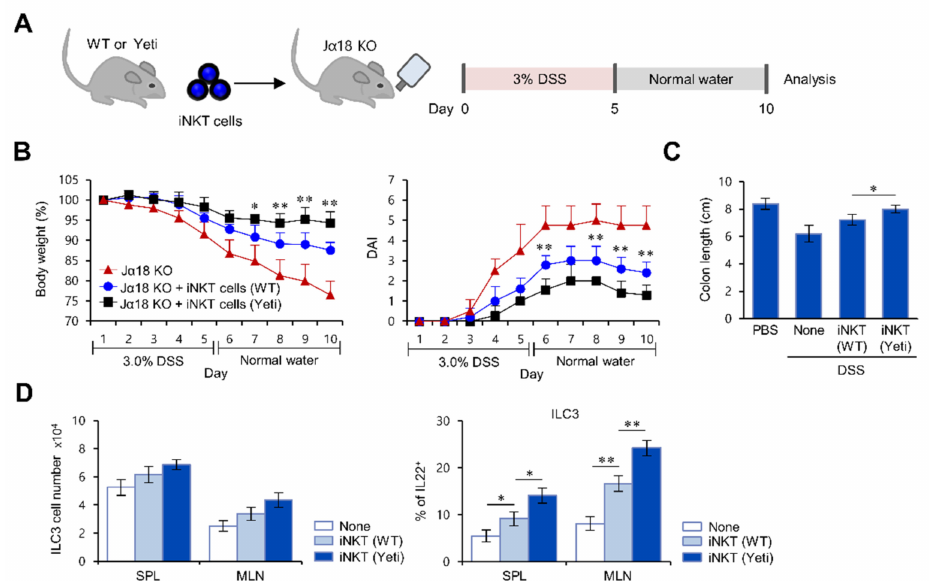
Figure 3. The suppressive effects of iNKT cells on IFN γ -mediated intestinal inflammation are closely associated with in- creased IL22 production by ILC3s. ( A ) J α 18 KO mice adoptively transferred with either WT or Yeti MLN iNKT cells (2 × 10 5 ) were treated with 3% DSS as described in Materials and Methods. ( B ) Daily body weight changes, DAI score, and ( C ) colon length of these mice were evaluated. ( D ) The absolute numbers and IL22 production by ILC3s (MHC II + ROR γ t + Lin − ) in the spleen and MLN from these mice were determined by flow cytometry on day 10. The mean values ± SD ( n = 3; per group in the experiment; Student’s t -test; * p < 0.05, ** p < 0.01) are